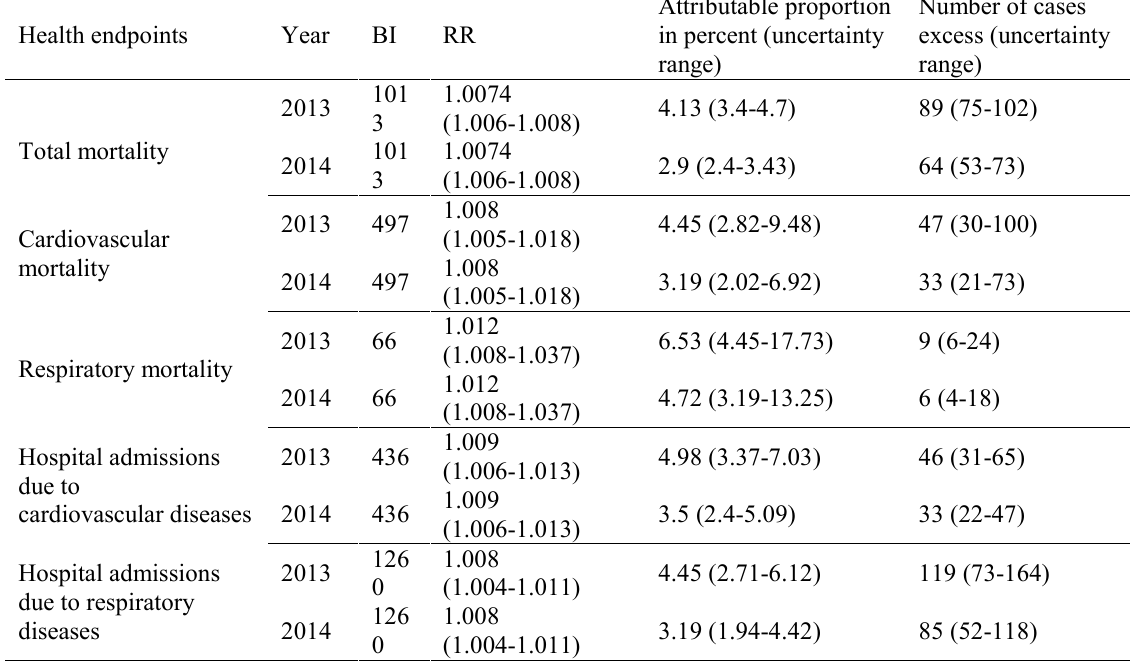
Attributable proportion Number of cases in percent (uncertainty excess (uncertainty range)